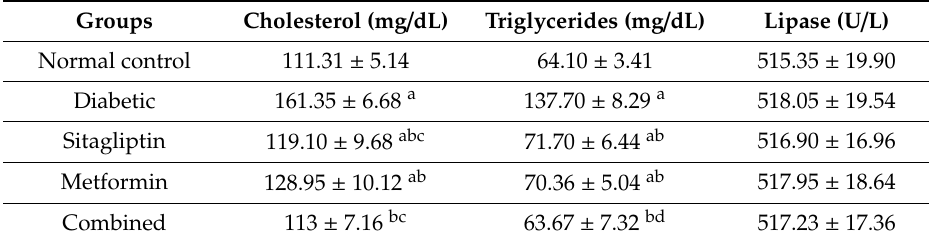
Table 5. Changes in lipid profile parameters and serum lipase in the di ff erent studied groups at the end of the treatment period (4